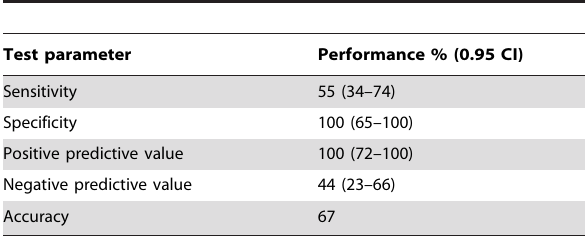
Table 2. PCR performance in confirmed cases (n=20) compared to cases with other parasitosis (n=